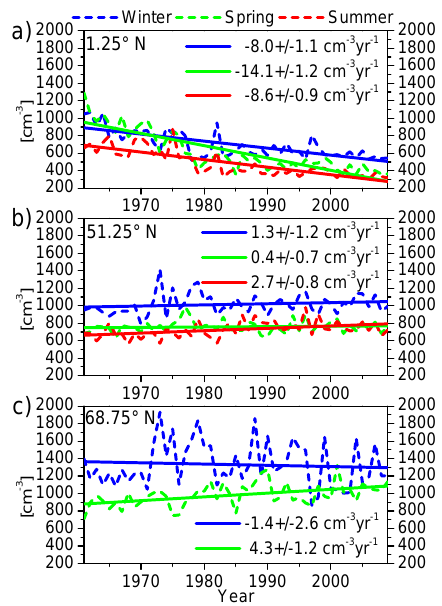
Figure 2. Long-term variations (dashed lines) and corresponding linear trends (solid lines) in the seasonally averaged nighttime mean concentration of the OH ∗ peak due to the variability in dynamics v = 6 and temperature in low (a) , middle (b) , and high (c) northern lati- tudes for winter (blue lines), spring (green lines), and summer (red